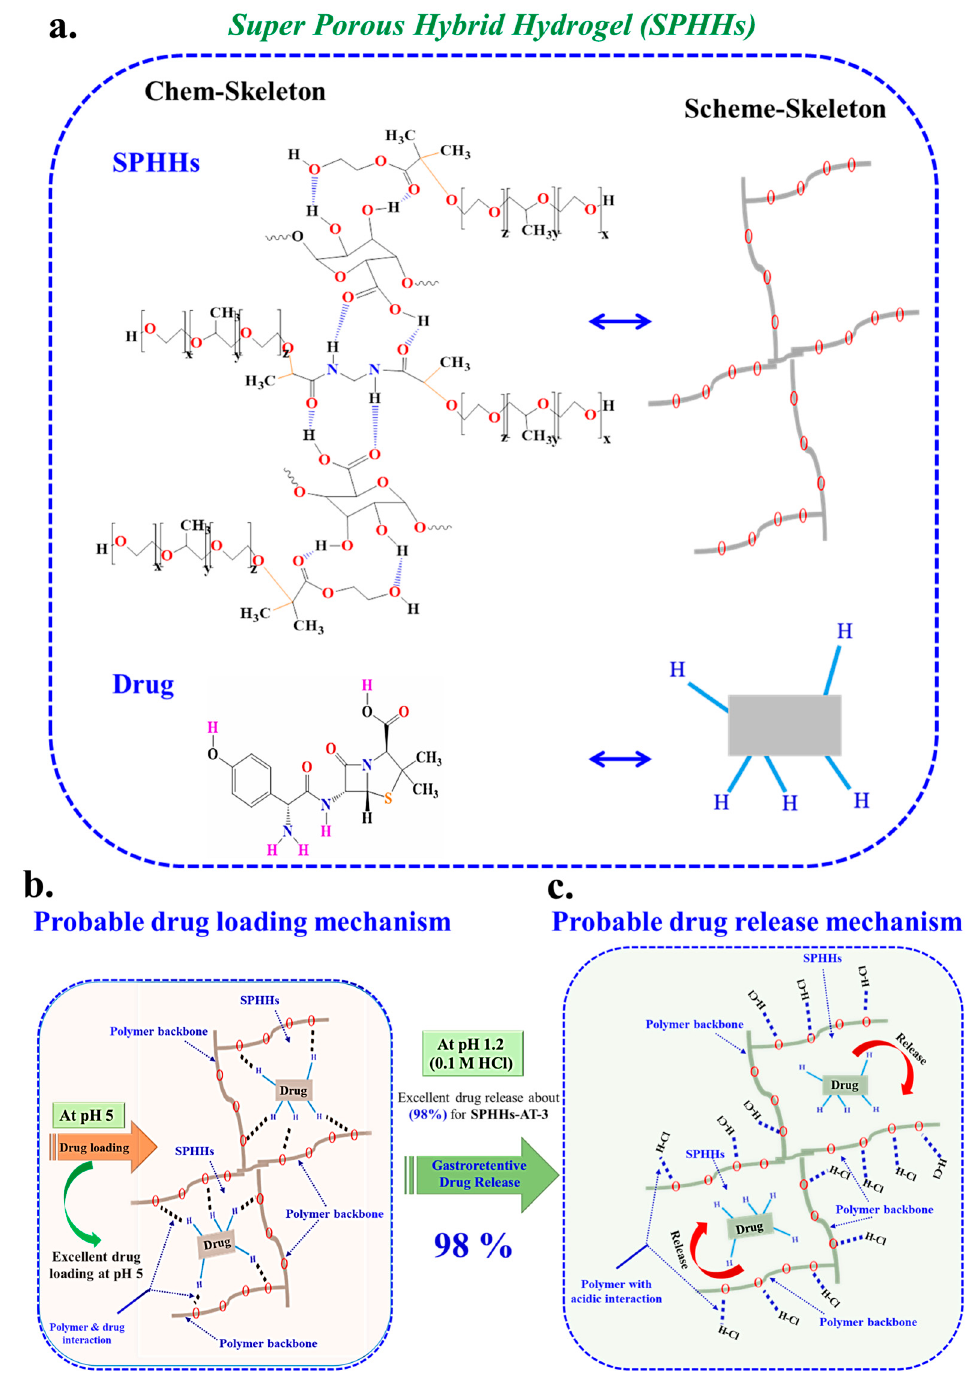
Figure 5. ( a ) The SPHHs structure depends on the chem-skeleton and scheme-skeleton. ( b ) The prob- able drug-loading mechanism at pH 5 for gastroretentive SPHHs and drug in the chem-skeleton [33]; ( c ) the presumed drug-release mechanism at pH 1.2 for SPHHs-AT [32,55]. The drug content assessment of dissimilar SPHHs preparations determined that the drug content was in the range of 95.36–98.05% of the total amount of AT in the SPHHs-AT (Table S3) [49,57]. The drug release originated from the amount of pectin and 2HEMA. It was observed to be inversely related to the amount of BIS. The in vitro drug release studies were carried out as shown ((a) pH 7.4, (b) pH 1.2 in Figure 6a–b’) [58]. The AT release from the SPHHs-AT reflected that the increase in the concentration of BIS and